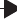
Fig. 2 Radiographic response of recurrent metaplastic breast cancer with a bulky chest wall mass and pulmonary metastases to pembrolizumab/nab-paclitaxel. PET CT images a at baseline depicting the large and destructive chest wall mass (SUV 11.0, 10.1 × 3.6 cm, blue arrow ), invading ribs, sternum, and pleura, b at 9 weeks (s/p three cycles) demonstrating a signi fi cant metabolic and anatomic response on the chest wall mass (SUV 5.6, 6.5 × 4.7 cm, blue arrow ), c at baseline depicting bilateral lung parenchymal ( red arrow ) and nodal metastases ( green arrow ), d at 9 weeks demonstrating a decreased number, size, and metabolic activity of pulmonary metastases and worsening cavitation ( red arrow ) as sign of favorable response to therapy. Additionally, the protruding mass (seen on the clinical photographs) is shown with necrotic debris. Complete response to the previously identi fi ed intensely FDG avid necrotic right internal mammary chain lymph node ( green arrow ). e Coronal image at baseline depicting the bulky right chest wall recurrence, extensive bilateral lung parenchymal and pleural metastases as well as nodal metastases. f Coronal image at 9 weeks demonstrating marked interval improvement in the right chest wall mass consistent with a partial treatment response, as well as interval decrease of multiple FDG avid nodal, pulmonary, and pleural